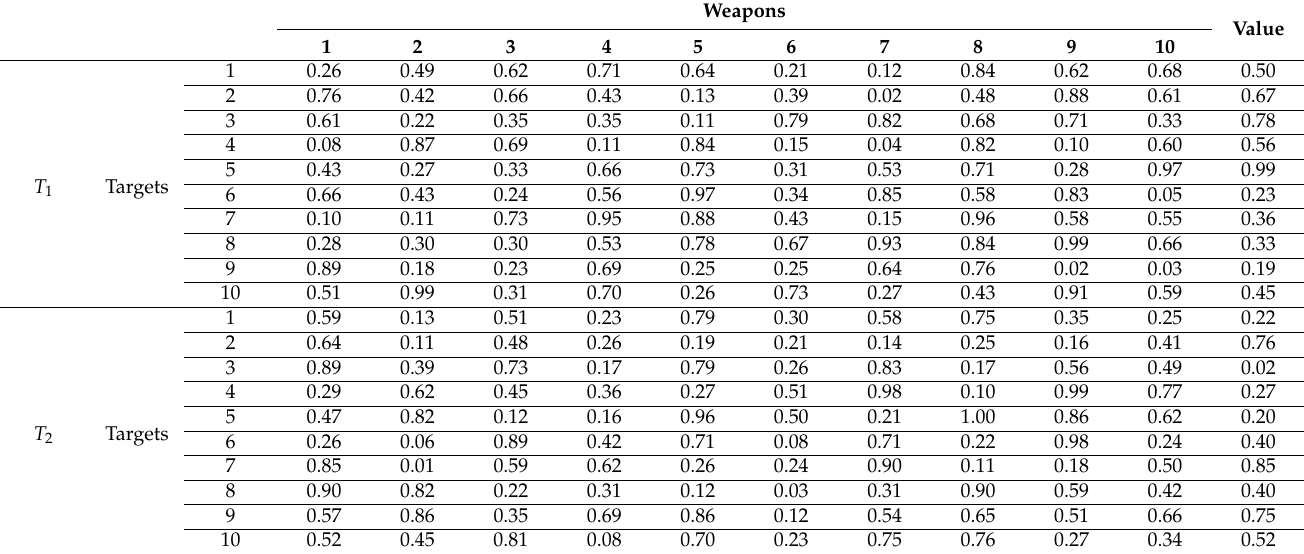
Table A2. Details of the destructive value of every target and the probability of kill for every weapon in the two component tasks of problem 2 in Table 2. Each task is a WTA problem.